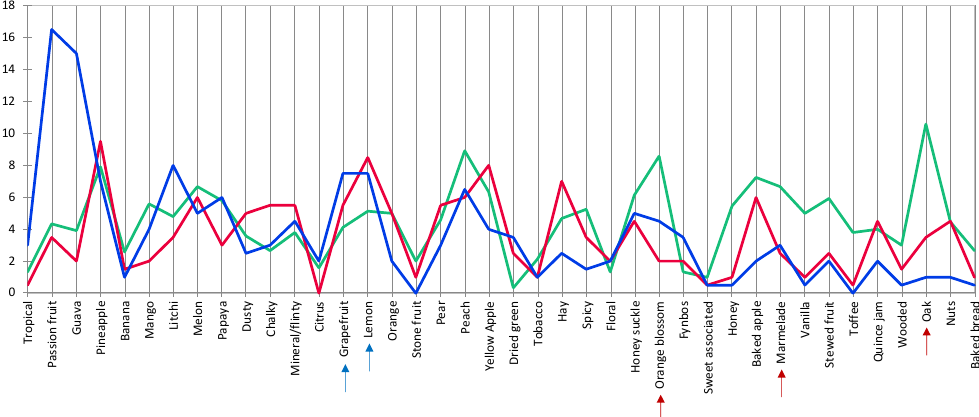
Figure 7. HCA cluster profile plot for Chenin Blanc. The blue and red arrows indicate negative and positive drivers of quality, respectively. The color of the graph lines corresponds to the clusters indicated in Figure 6.